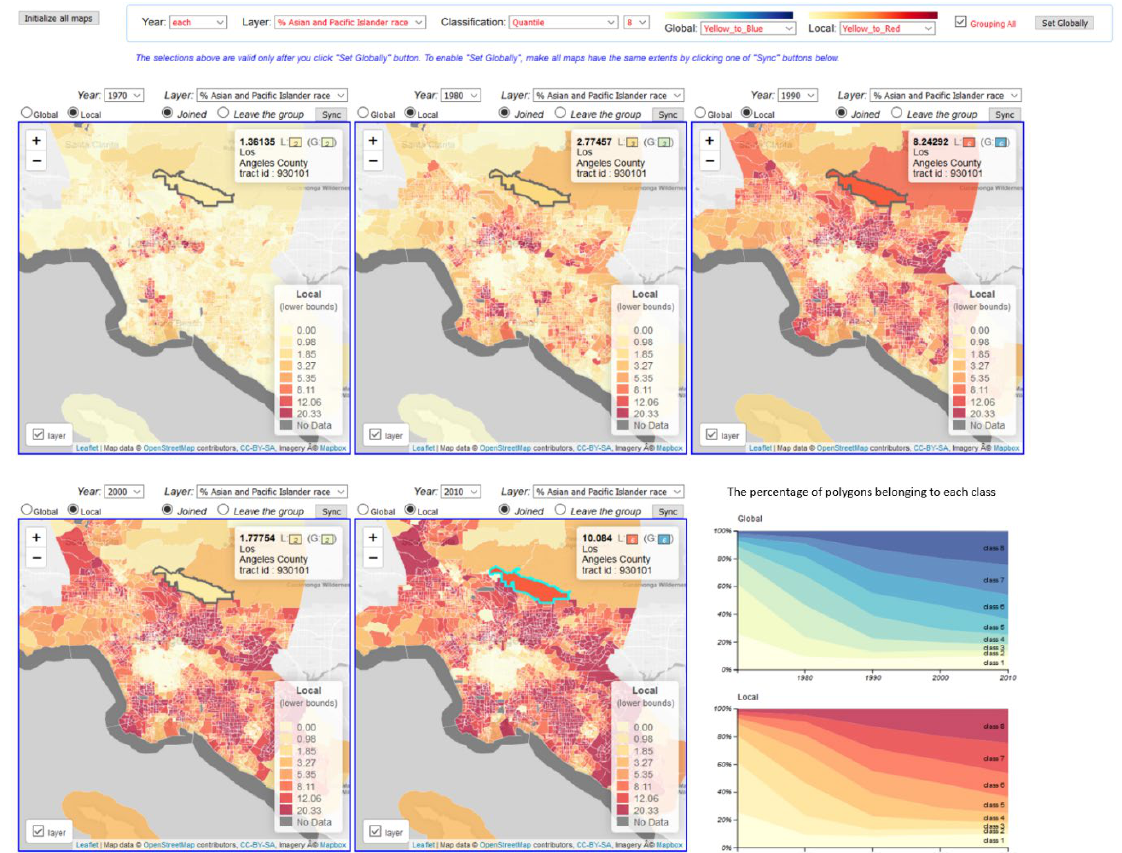
Figure 4. The second part of the user interface of Longitudinal Neighborhood Explorer (LNE). Maps represent the percentage of Asians and Pacific Islanders with the same classification intervals over all maps. It is one of the views created from the Adaptive Choropleth Mapper.